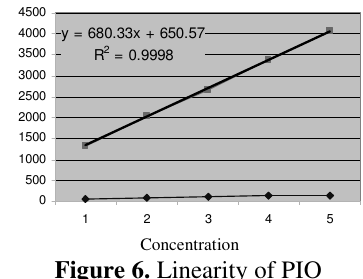
Figure 4. Linearity of GLI GLI is Glimepiride